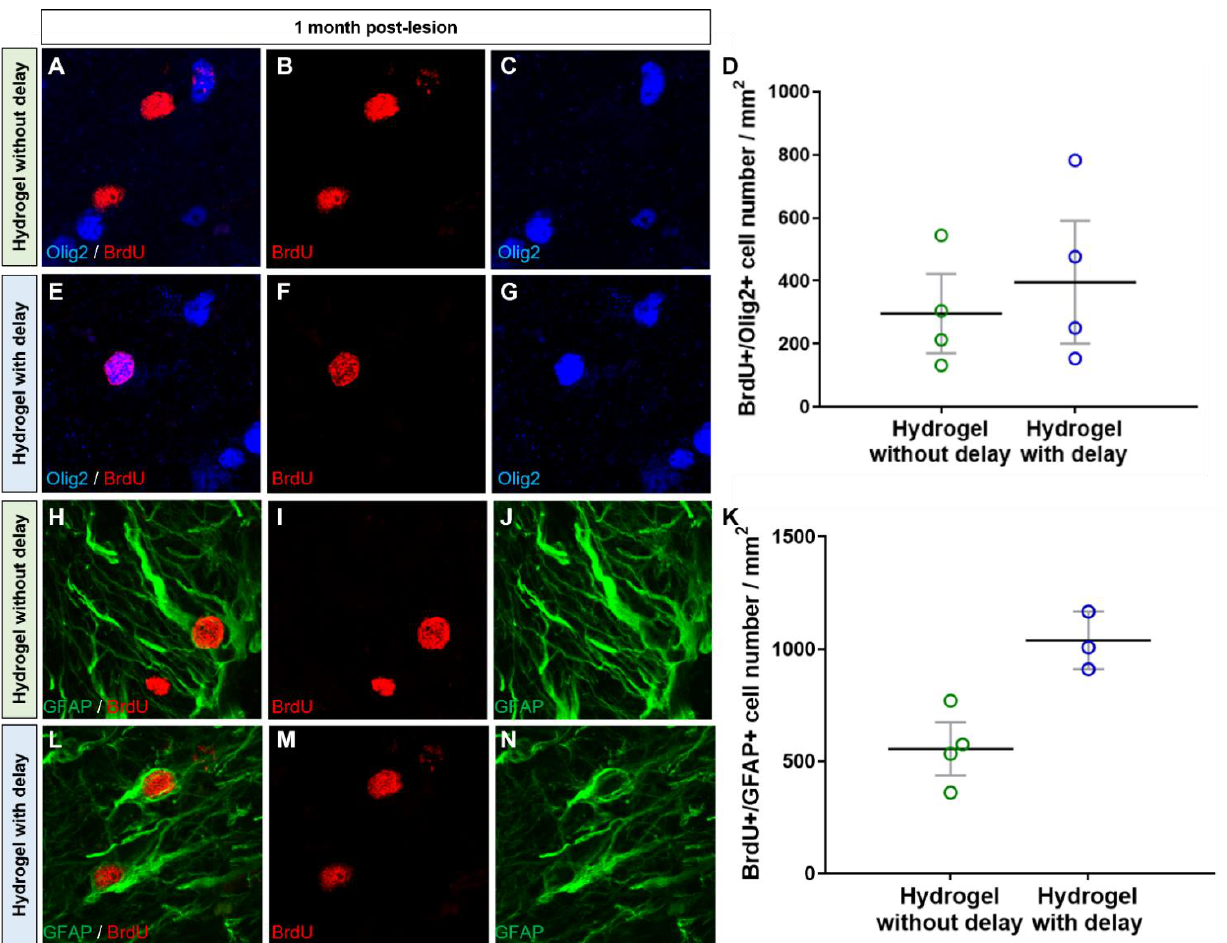
Figure 8. Newly generated oligodendrocytes and astrocytes into hydrogel. ( A – N ) Representative immunofluorescence staining of newly generated BrdU cells (red) colocalized with Olig2 (blue, ( A – G )) or with GFAP (green, ( H – N )) in delay ( A – C , H – J ) or no delay hydrogel implanted groups ( E – G , L – N ). ( D , K ) Quantitative analysis of the BrdU+/Olig2+ cells ( D ) or BrdU+/GFAP+ cells ( K ) in no-delay (green) or delay (blue) hydrogel implanted groups. Mann–Whitney